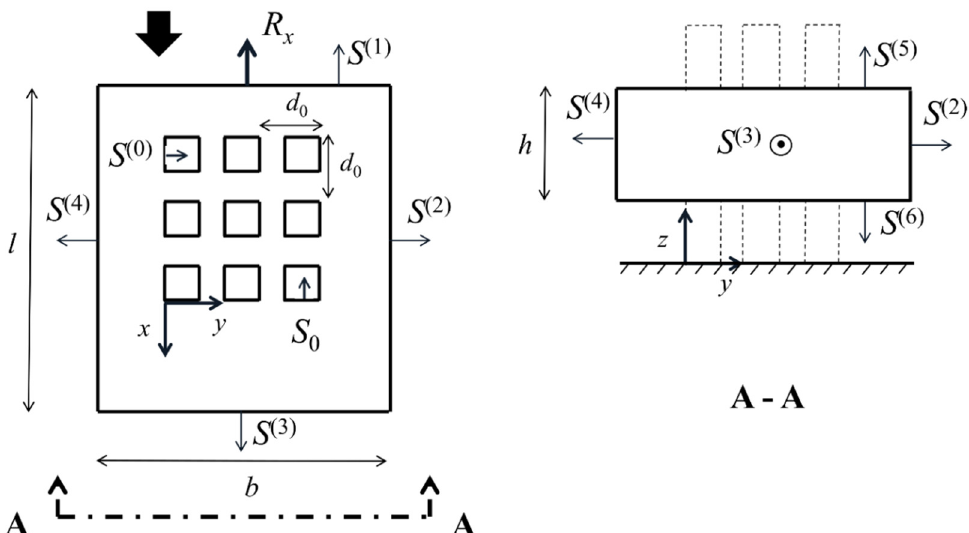
Figure 1. General depiction of the control volume in the x - y and y - z planes. Black thick arrow indicates the flow direction.